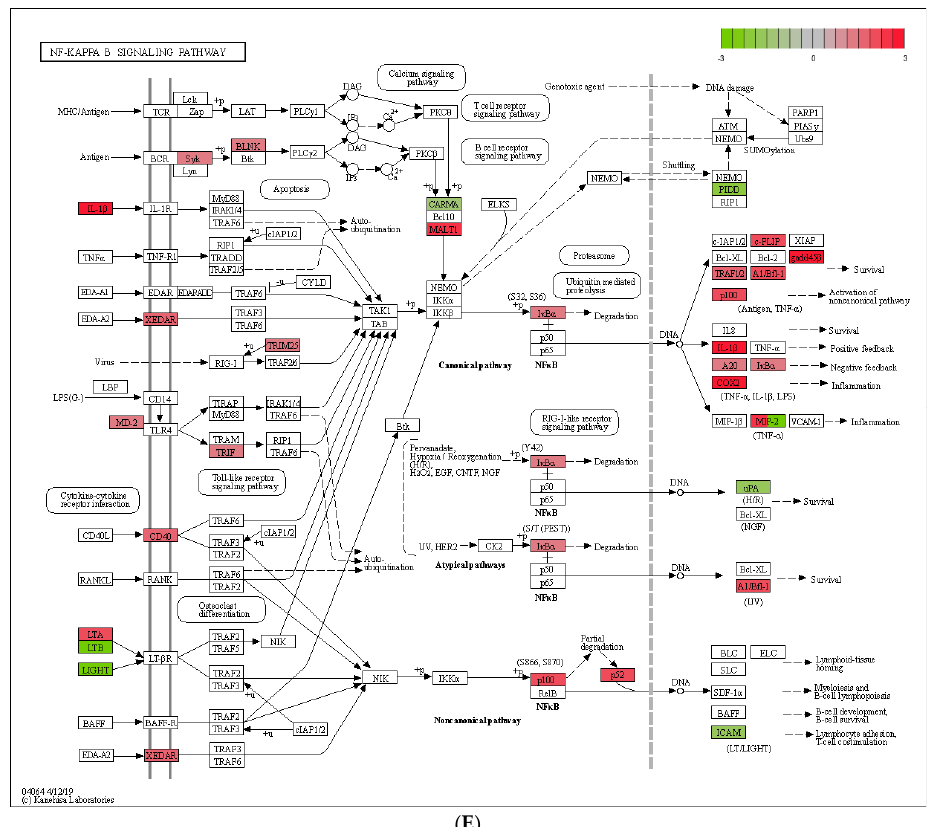
Figure 6. Effects of GEP-1 on gene changes in RAW 264.7 macrophage cells compared with the normal group (NG). ( A ), volcano plots of RAW 264.7 cells; ( B ), GO enrichment analysis of DEGs; ( C ), KEGG analysis of DEGs; ( D ), Top 20 enriched KEGG pathways. ( E ), DEGs in the NF- κ B signaling pathway from RNA-seq.